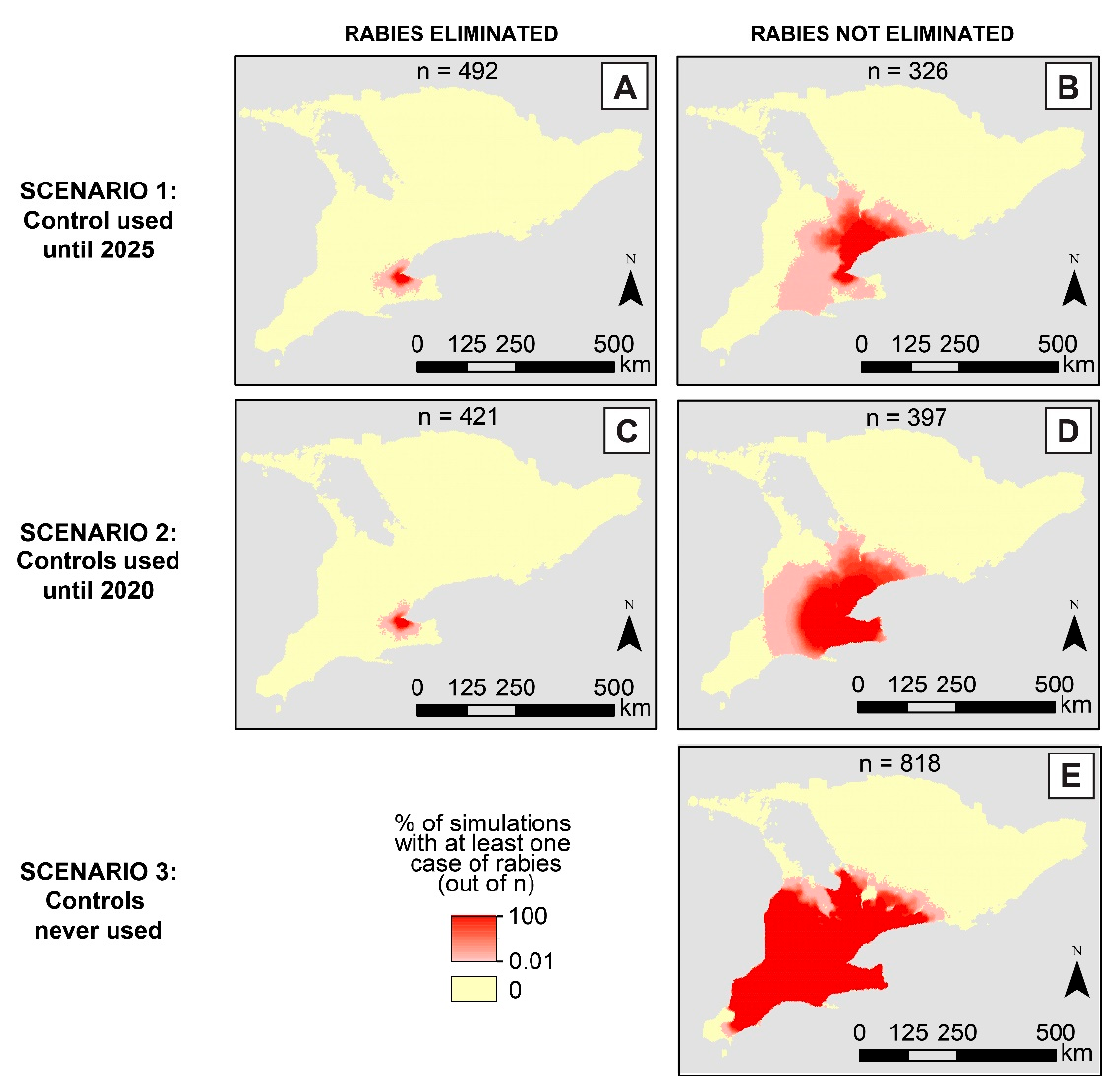
Figure 3. Maps showing the percentage (%) of simulations that predicted at least one raccoon rabies case per 10-km 2 grid cell between November 2015 and December 2025. Panels ( A , C ) summarize simulations predicting rabies elimination in Scenarios 1 and 2, respectively, where simulations with rabies die off in the first week were removed ( n = 182). Panels ( B , D , E ) summarize simulations predicting rabies was not eliminated in Scenarios 1, 2, and 3, respectively. The number of simulations used to calculate percentages per map is shown above each panel. For Scenario 3, rabies was only predicted to be eliminated when the disease died off naturally within the first week following its introduction. Therefore, the map for those simulations was not shown.